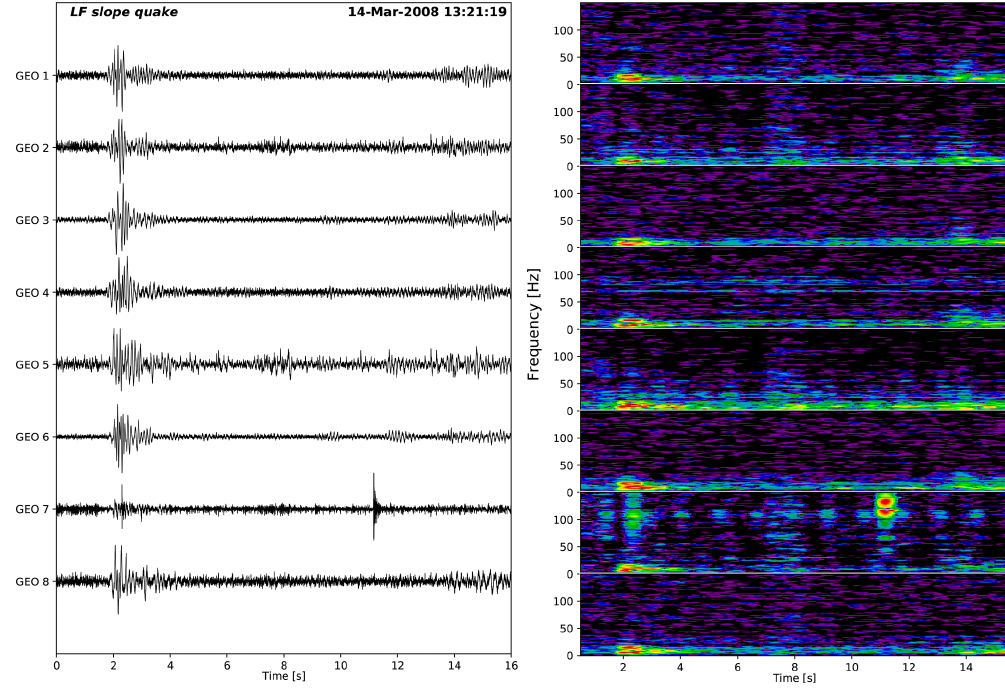
Figure B2. Example of a low-frequency slope quake. A stronger spurious signal was recorded on geophone 7.